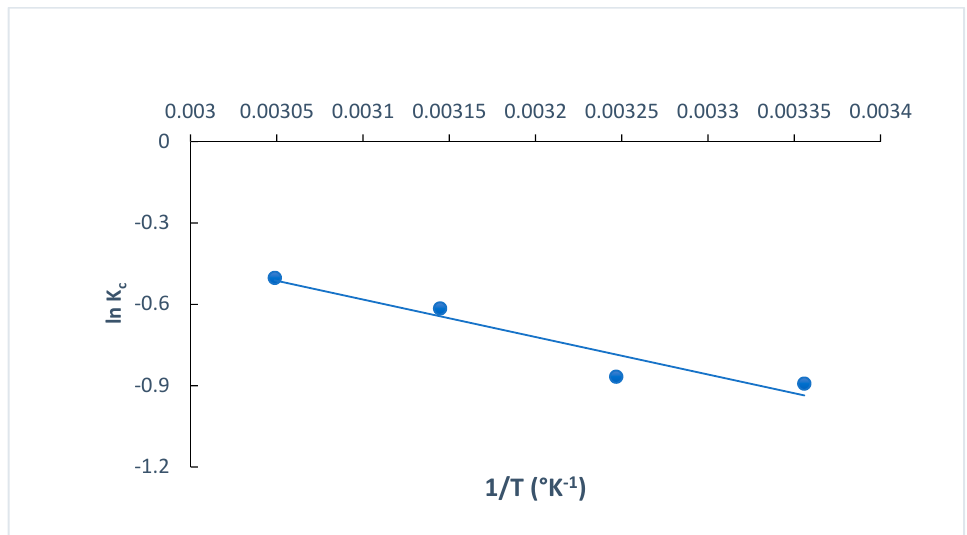
-1.2-0.9-0.6-0.300.003 Figure 13. The plots of ln K c versus 1/ T for the adsorption of MB dye onto O -CM-chitosan hydrogel. Table 4. Thermodynamic data for the adsorption of MB dye by O -CM-chitosan hydrogel at different temperatures. Figure 14. Arrhenius plot for adsorption MB dye onto O -CM-chitosan hydrogel. 3.3. Desorption and Regeneration Studies MB dye was desorbed from O-CM chitosan hydrogel, and the desorption percentage was estimated according to Equation (23). The desorption percentage reached 78%, 63%, 55% and 48% at the first, second, third and fourth cycles, respectively. These results that confirm that the adsorption of MB dye onto O-CM chitosan hydrogel occurs through elec- trostatic interaction. This finding confirms that the regeneration and reuse of the investi- gated adsorbent is possible.